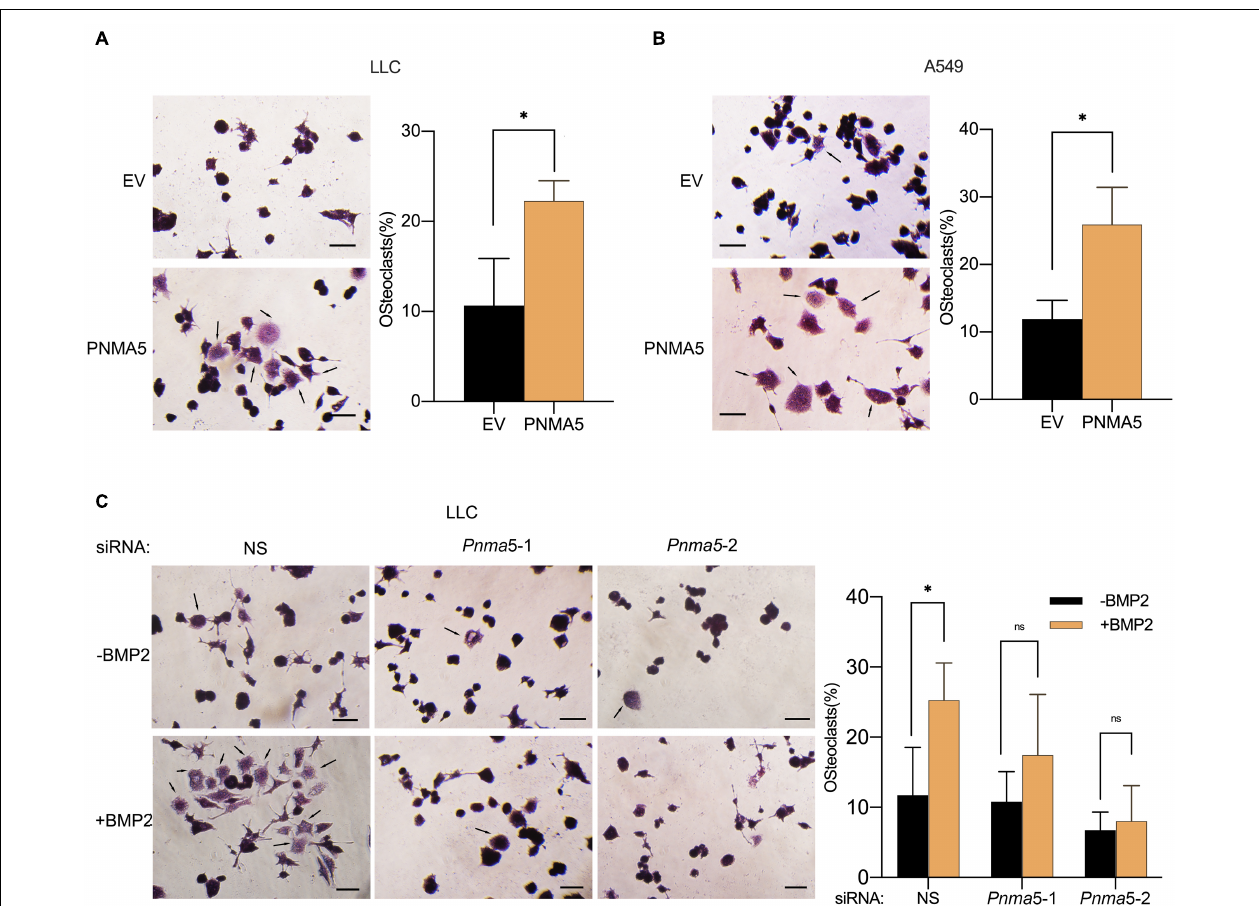
FIGURE 5 | BMP2 signaling enhanced NSCLC cells-induced osteoclasts differentiation via PNMA5. (A,B) 3 × 10 4 empty vector (EV) and PNMA5 overexpressed LLC (A) or A549 (B) cells were seeded into the Corning Cell Culture Inserts with polycarbonate membrane (Transwell@, 0.4 µ m pore size) and 3 × 10 4 RAW 264.7 cells were seeded below the polycarbonate membrane into the wells of the 6-well co-culture plates (Corning). TRAP staining was conducted for RAW 264.7 cells cultured for 6 days by a leukocyte acid phosphatase kit. Representative photos were shown. Scale bars, 50 µ M. Average Trap + cell numbers of at least three fields were calculated and shown on the right. Black arrows showed the osteoclasts. The p -value was based on the Student’s t -test. * P < 0.05. (C) 3 × 10 4 siRNA scrambler, siRNA Pnma5 -1 and siRNA Pnma5 -2 expressed LLC cells were seeded into the Corning Cell Culture Inserts with polycarbonate membrane (Transwell@, 0.4 µ m pore size) and 3 × 10 4 RAW 264.7 cells were seeded directly into the wells of the 6-well co-culture plates (Corning). TRAP staining was conducted for RAW 264.7 cells cultured for 6 days by a leukocyte acid phosphatase kit. Representative photos were shown. Scale bars, 50 µ M. Average Trap + cell numbers of at least three fields were calculated and shown on the right. Black arrows showed the osteoclast. The p -value was based on the Student’s t -test. * P <